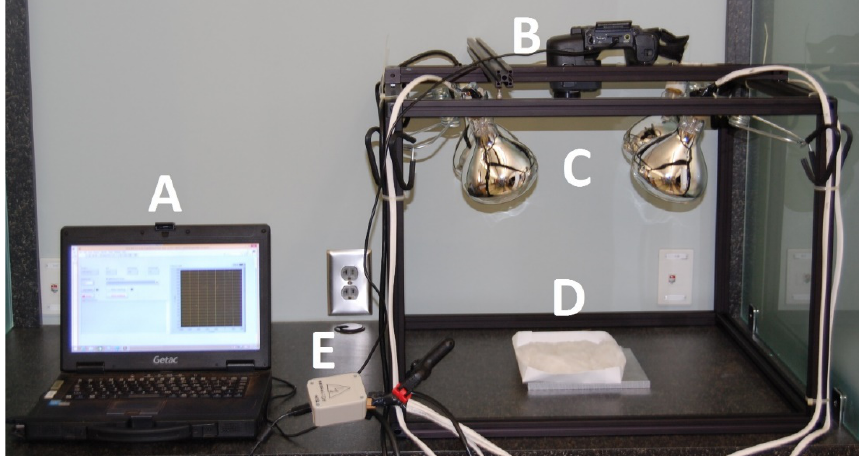
Figure 3. Pulsed thermography system physical components. ( A ) operating terminal; ( B ) thermal camera; ( C ) heat lamps; ( D ) sample stage; ( E ) USB power relay for lamp control.